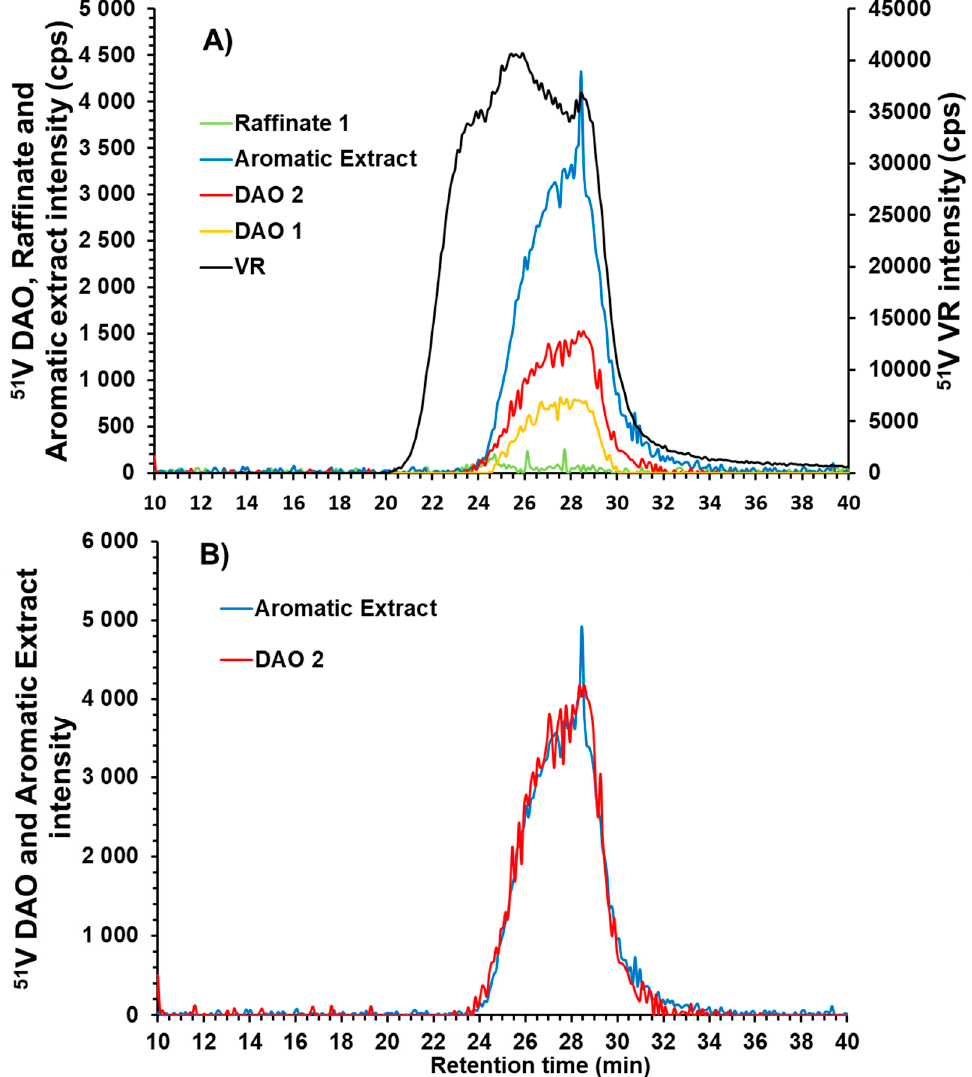
Figure 6. Chromatogram of vanadium-containing molecules by GPC-ICP HR MS for aromatic extract, de-asphalted oil (DAO 1), DAO feed of furfural (DAO 2), raffinate 1, and VR ( A ) and normalized chromatograms for aromatic extract and DAO 2 ( B ).